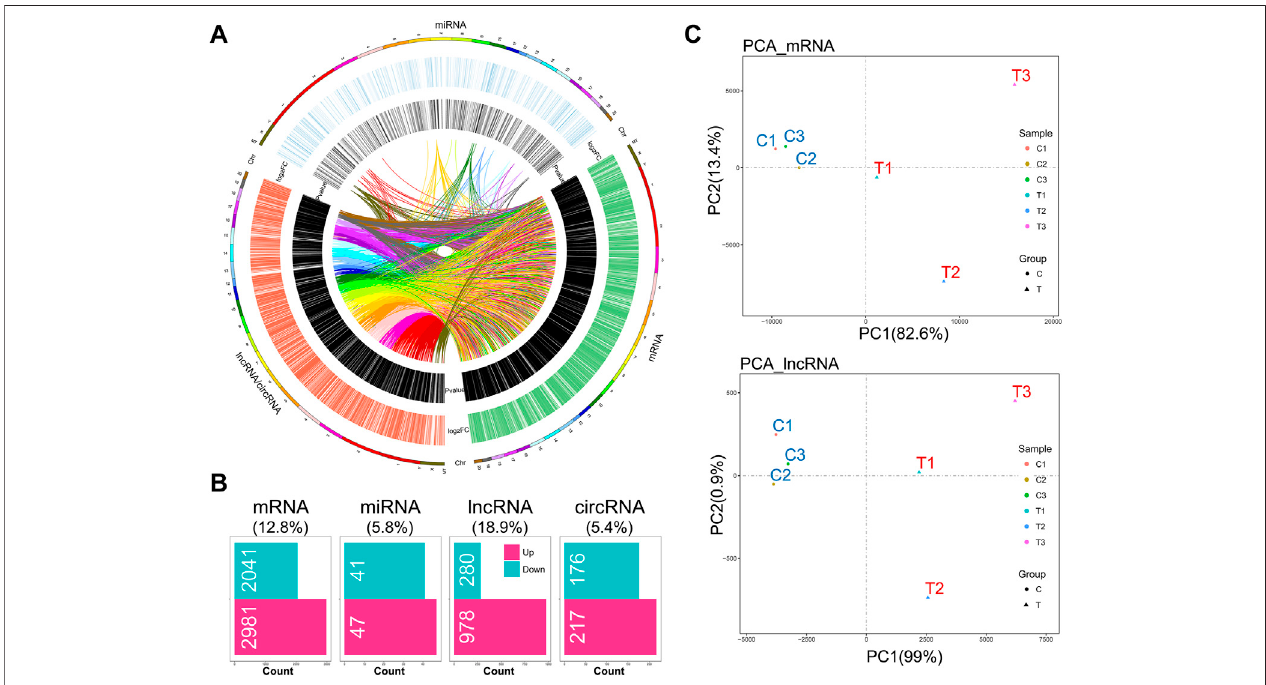
FIGURE 1 | Hallmark remodeling of RNA whole transcriptomic landscape in OA-like chondrocytes as a response to mechanical stress. (A) Transcriptomic landscape of mechanical stress-stimulated OA-like chondrocytes, including mRNA, miRNA, and lncRNA/circRNA, based on gene co-expression analysis. (B) A total of 5,022 differentially expressed mRNAs (DEMs), 88 differentially expressed miRNAs (DEMIs), 1,259 differentially expressed lncRNAs (DELs), and 393 differentially expressed circRNAs (DECs) were identi fi ed in the comparison of the mechanical stress-stimulated group and the control group (FDR < 0.05, |log2FC| > 1). (C) Principal component analysis of the mechanical stress-stimulated group and the control group based on mRNA pro fi les or lncRNA pro fi les. The mRNA transcriptome shows high relevance with the lncRNA transcriptome of OA-like chondrocytes.